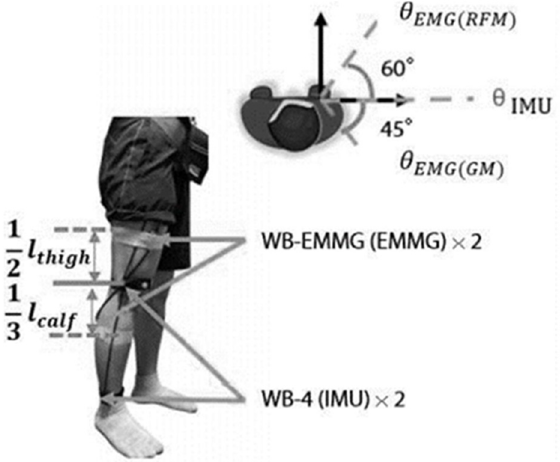
Figure 6. Position of IMU & sEMG sensors setup in the experiment.